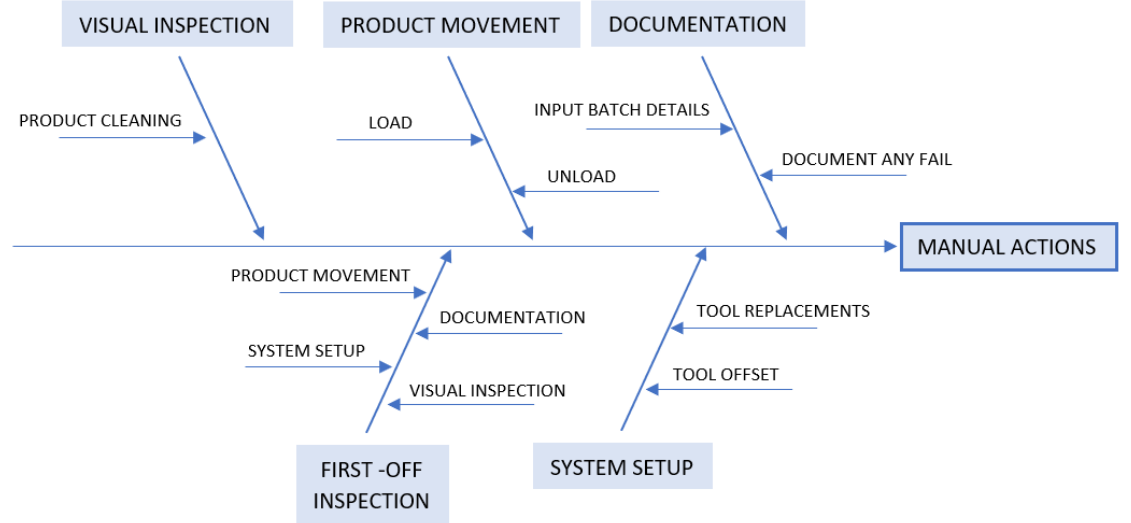
Figure 10. Ishikawa diagram of manual actions in milling operation 2.